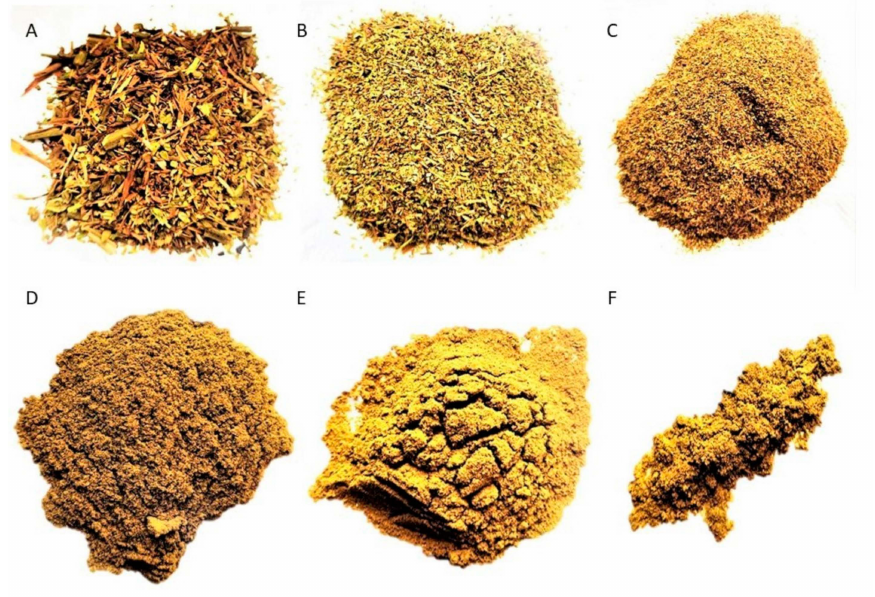
Figure 4. Nicotiana tabacum var. Virginia sieved fractions from ground inflorescence. ( A ) 840 µ m.